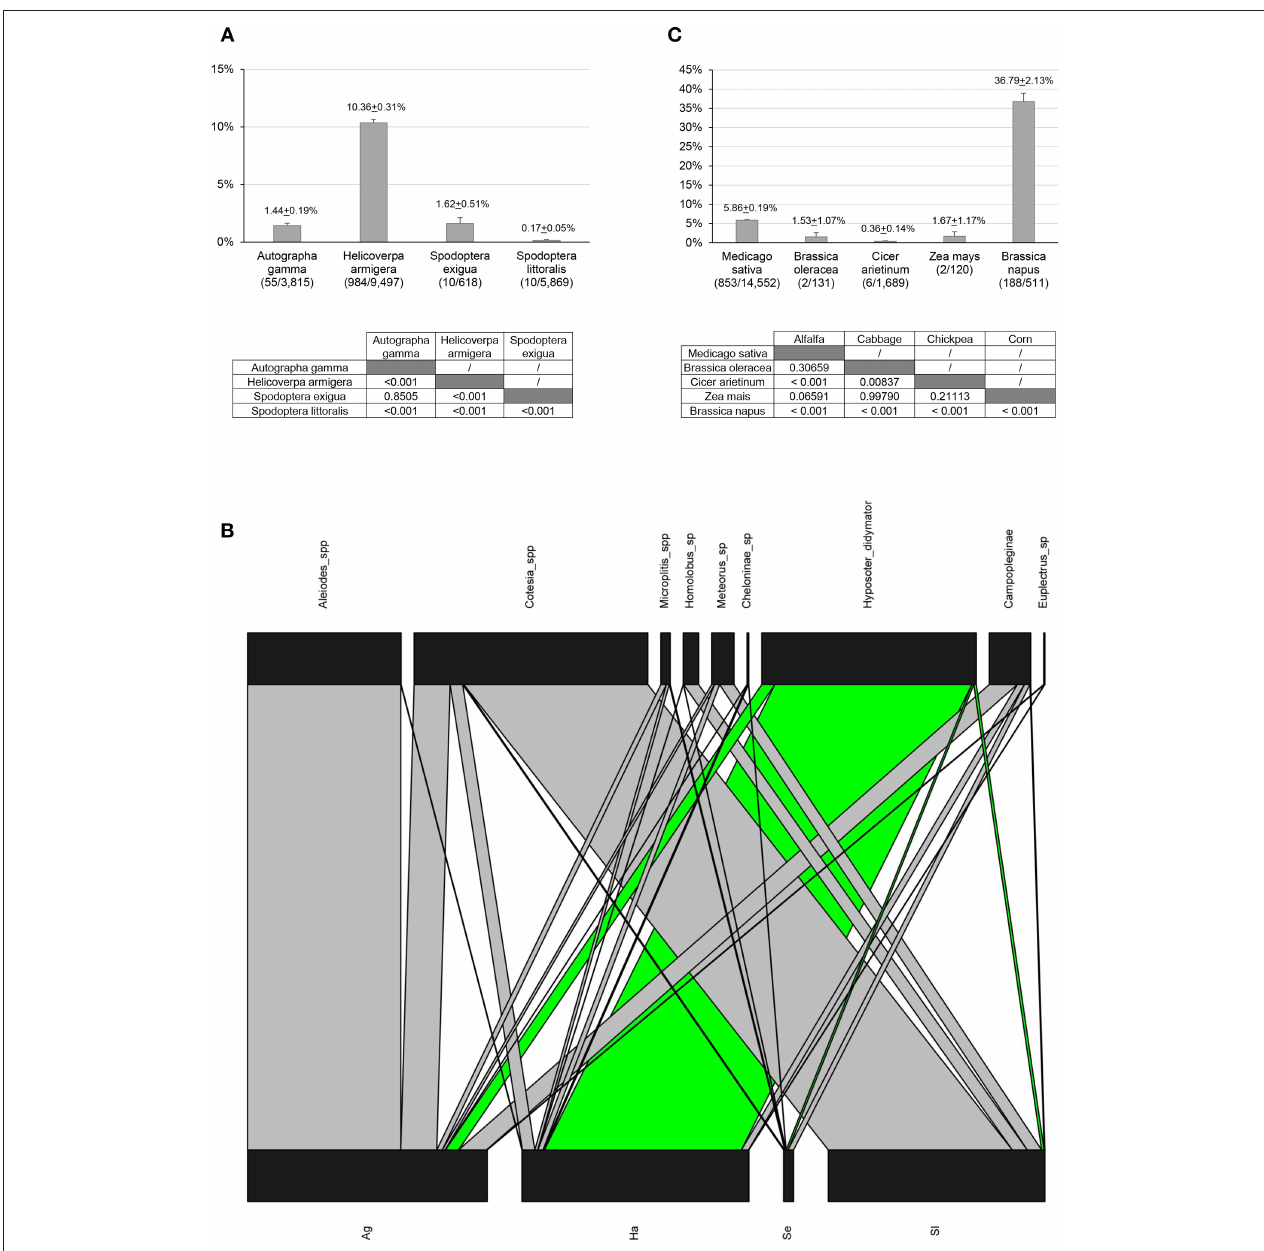
FIGURE 2 | Natural parasitism survey. (A) Parasitism rates (% ± SE) by H. didymator for 4 noctuid species. Statistical analyses are indicated below the graph (parasitism rates pairwise comparisons). (B) Quantitative food-web network: larval parasitoid communities interacting with H. didymator . The bottom bars represent the host species (Ag = Autographa gamma , Ha = Helicoverpa armigera , Se = Spodoptera exigua , Sl = Spodoptera littoralis ) whereas the top bars represent parasitoid species. The width of the bars is a proportional representation of species abundances. The host-parasitoid interactions involving H. didymator are depicted in green. (C) Parasitism rates (% ± SE) by H. didymator for 5 different host plants. Statistical analyses are indicated below the graph (parasitism rates pairwise comparisons). For A and C: the number of parasitized caterpillars relative to the number of caterpillars collected in the fields is indicated in parentheses at the bottom of the graph axis; refer to the Supplemental Table 1 for details on the collected